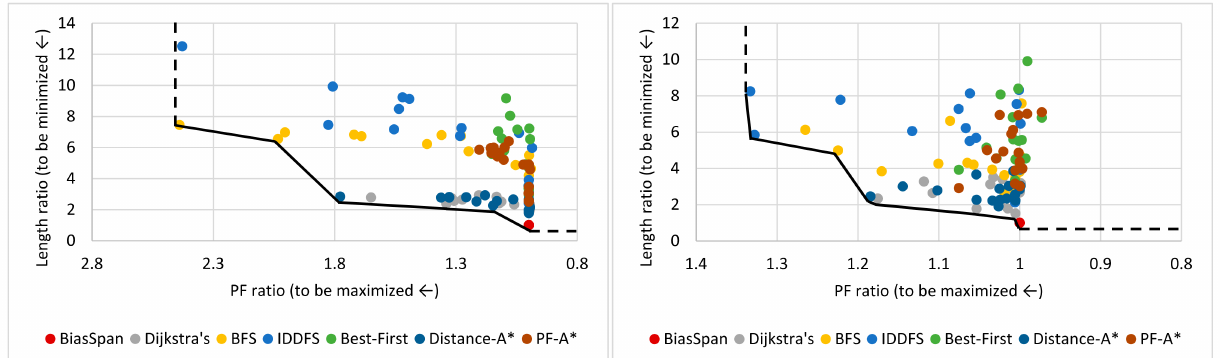
Figure 4. Pareto-efficient frontier and solutions under different area ranges in Chicago ( left ) and Tainan ( right ) dataset. All solutions for BiasSpan are located at (1, 1) and achieve the Pareto optimal. The illustrated Pareto-efficient frontier indicates that the solutions that are located on which retains no neighboring solutions that could obtain an improved satisfaction in certain criteria without losing in some other criteria (e.g., either length ratio or PF ratio for our evaluation criteria); that is, if there is no scope for further Pareto improvement, the solutions achieve the Pareto optimal among all candidates and constitute the Pareto-efficient frontier.